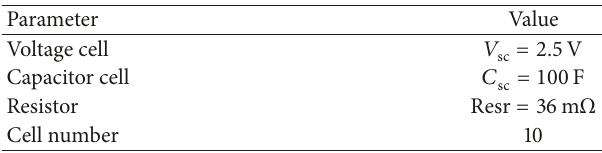
Table 2: Ultracapacitor specifications.